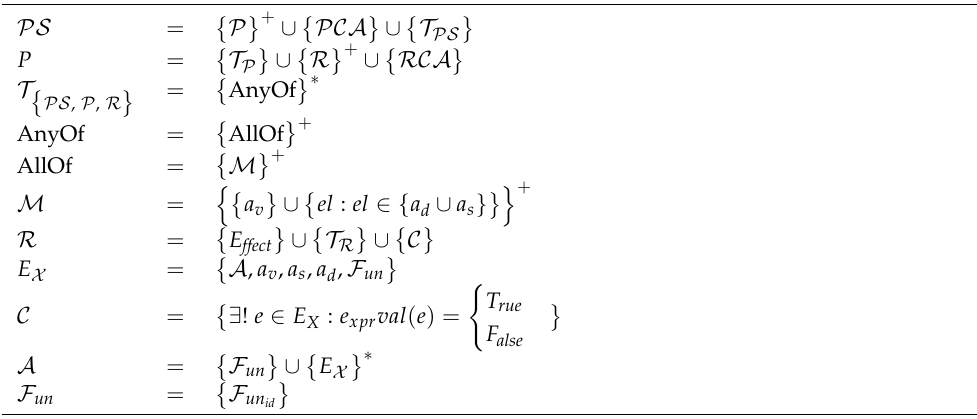
Table 3. Definition of syntactical categories with formalization on